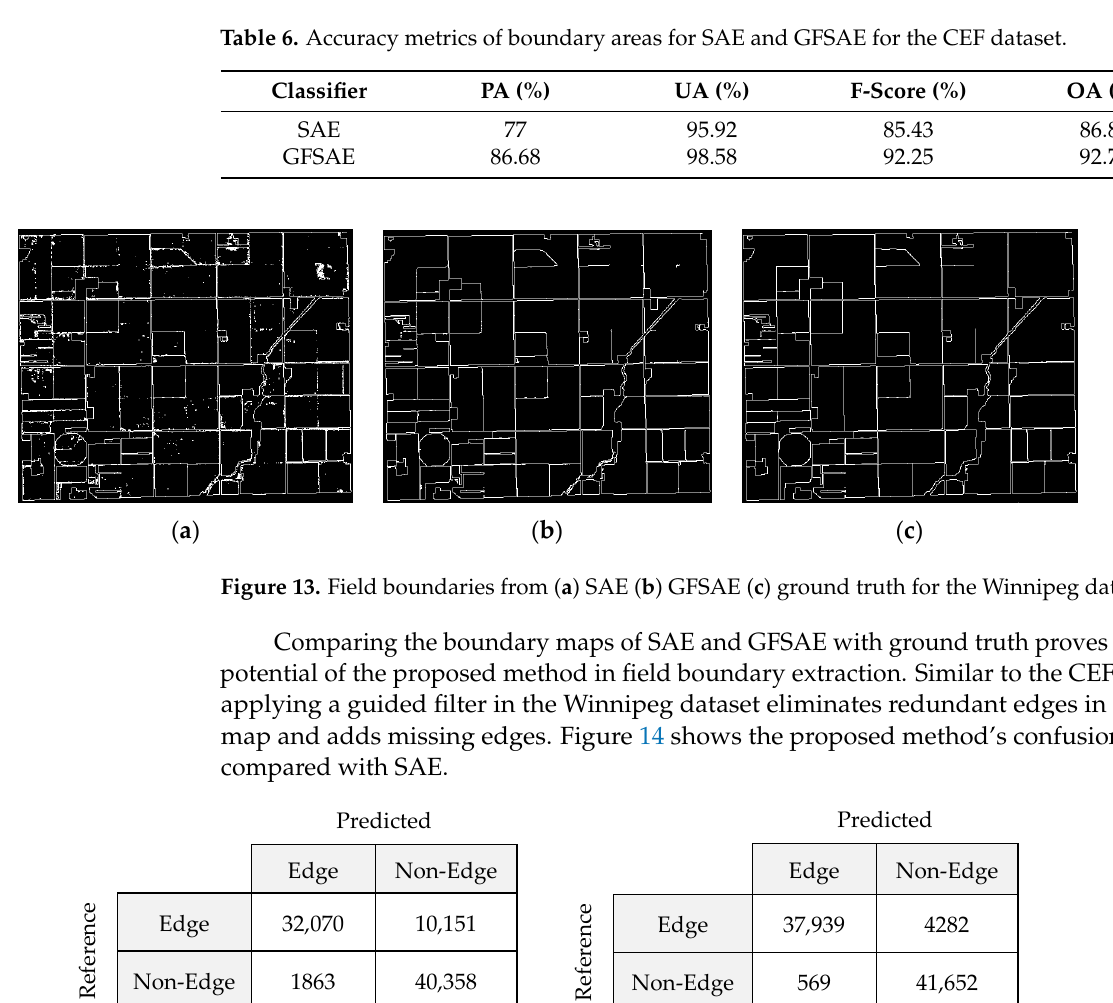
Figure 13. Field boundaries from ( a ) SAE ( b ) GFSAE ( c ) ground truth for the Winnipeg dataset . Comparing the boundary maps of SAE and GFSAE with ground truth proves the high potential of the proposed method in field boundary extraction. Similar to the CEF dataset, applying a guided filter in the Winnipeg dataset eliminates redundant edges in the SAE map and adds missing edges. Figure 14 shows the proposed method’s confusion matrix compared with SAE. Figure 14. Confusion matrix from ( a ) SAE ( b ) GFSAE for the Winnipeg dataset. Type I error in the SAE method is 1863, meaning these pixels are incorrectly assigned to the edge class. By implementing a guided filter, 70% of those pixels are removed. Moreover, analyzing type II errors in both confusion matrices shows that the proposed method can restore 58% of edge pixels that are not detected in the SAE algorithm. Table 7 presents accuracy metrics obtained from confusion matrices on the Winnipeg